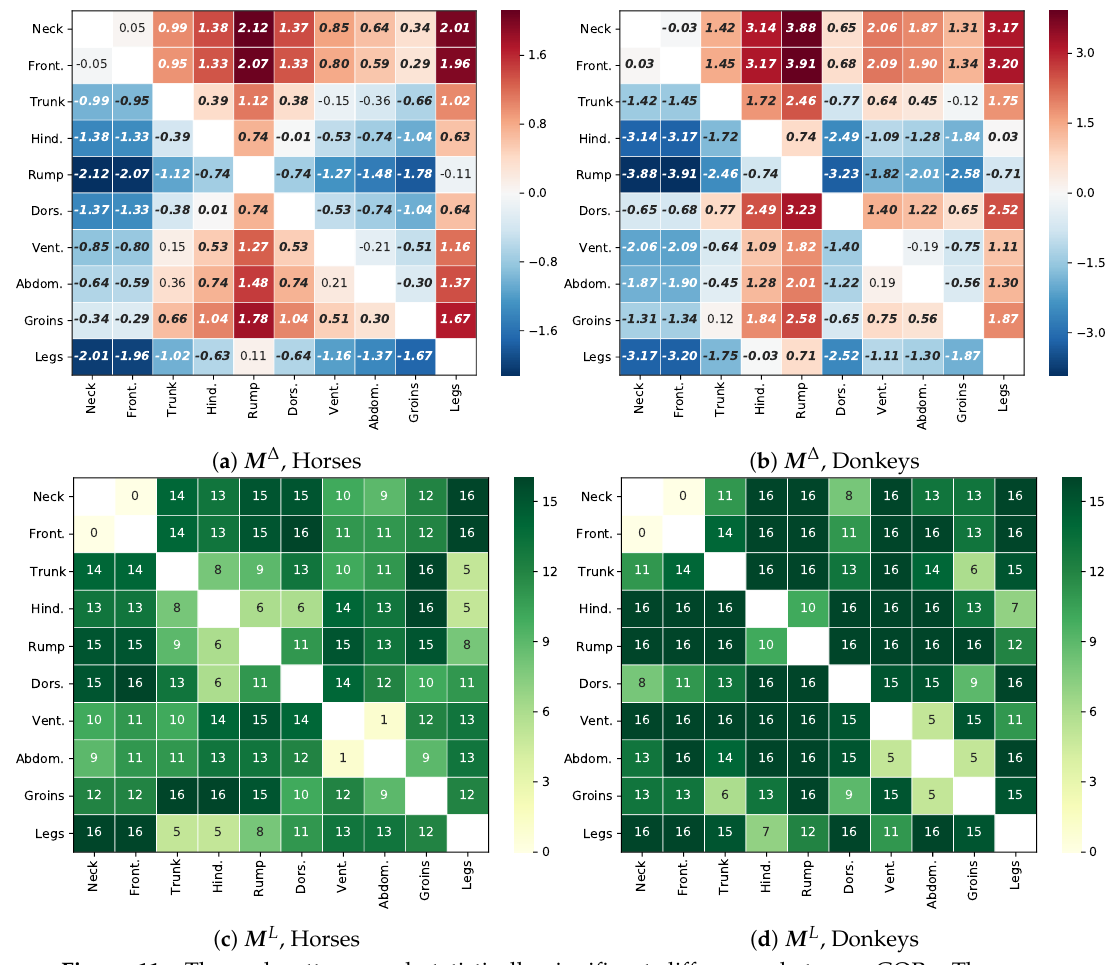
Figure 11. Thermal patterns and statistically significant differences between GORs. The upper panels present the matrix of differences within one species: ( a ) horses; ( b ) donkeys; e.g., the value = − 2.12 in the cell [ 4,0 ] in Panel ( a ) is the difference between the mean temperatures for the pair M ∆ [ 4,0 ] Rump and Neck , indicating that the Rump GOR is colder. Bold font indicates “global” statistical significance of this difference ( p < 0.001). The bottom panels present tables for ( c ) horses and ( d ) donkeys, with the number of animals for which the corresponding temperature difference in the table above is statistically significant considering individual thermal pattern of this animal ( p < 0.001); = 15 in Panel ( c ), which indicates that the pattern Rump and Neck is locally e.g., the value M L [ 4,0 ] significant for 15 horses. A stable pattern should be statistically significant simultaneously for all data combined and for each of the 16 animals of a given